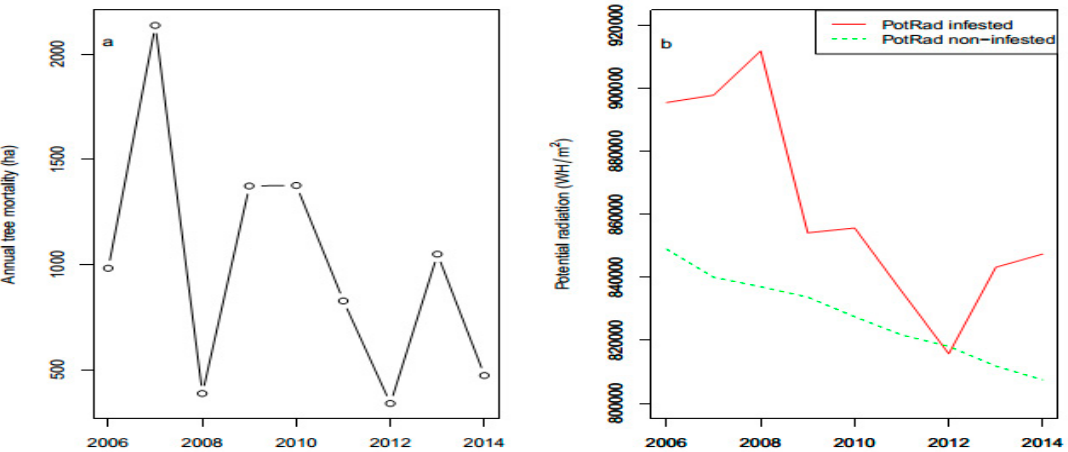
Figure 3. Time series of bark beetle infestations ( a ) and potential radiation of infested and non-infested pixels from 1 April to 31 October in the High Tatra Mountains, 2006–2014 ( b ).